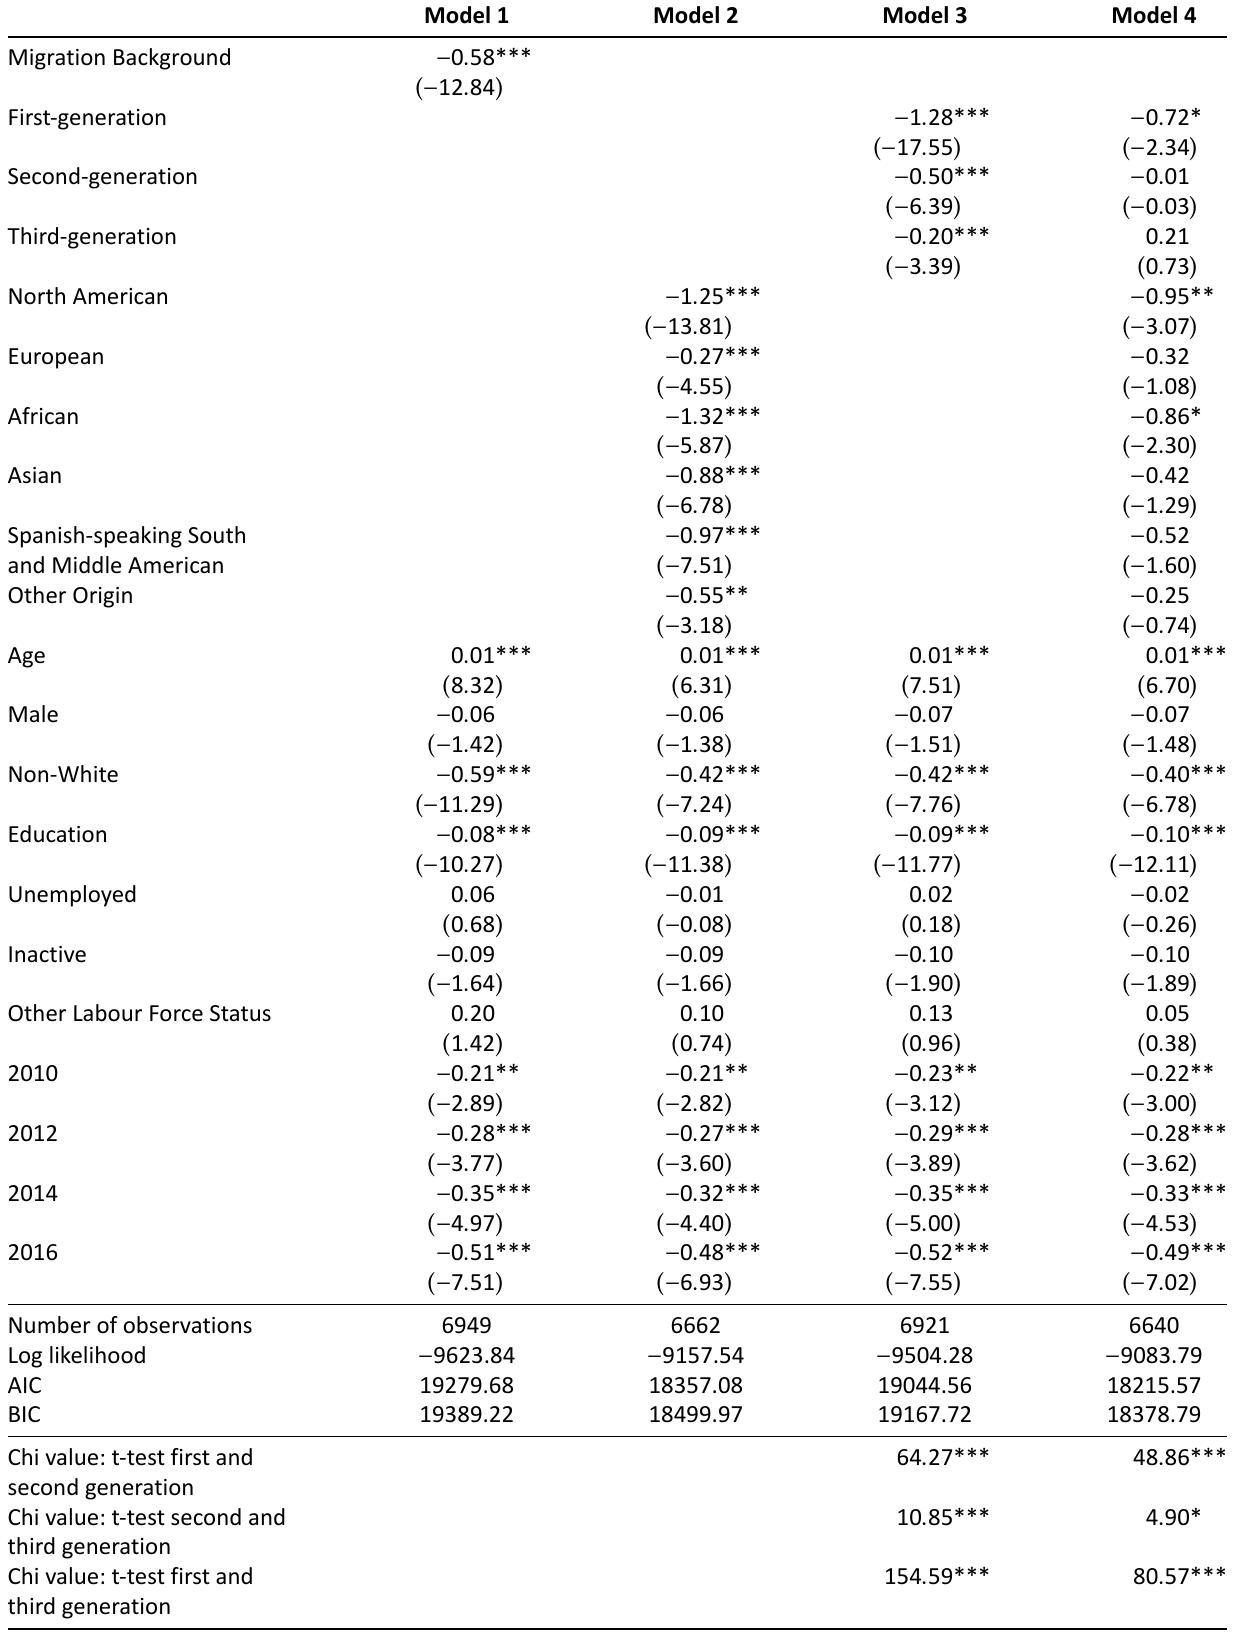
Table 2. Ordered logit models with general migration background and separate migration